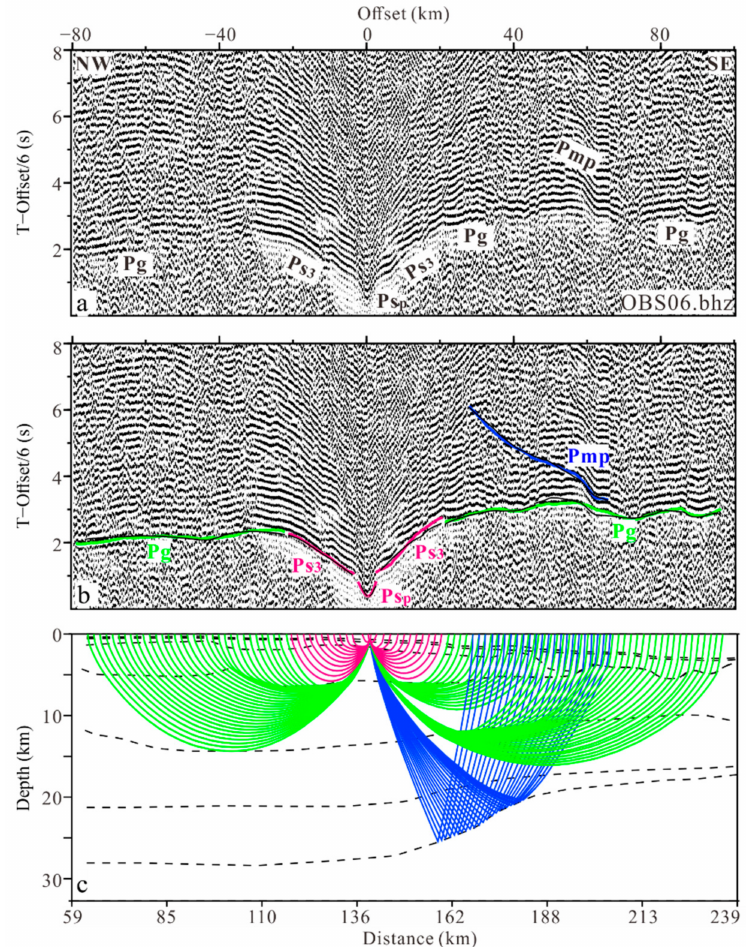
Figure 2. ( a ) Vertical seismic profile from OBS 06, with a reduction velocity of 6 km/s and a band-pass filter of 3–10 Hz (see Figure 1 for location). ( b ) The phase picking and fitting of OBS 06. The coloured lines represent picked travel times, and the thin, black lines represent calculated travel times from the final velocity model. ( c ) Ray tracing for OBS 06. Different line colours correspond to different phases.